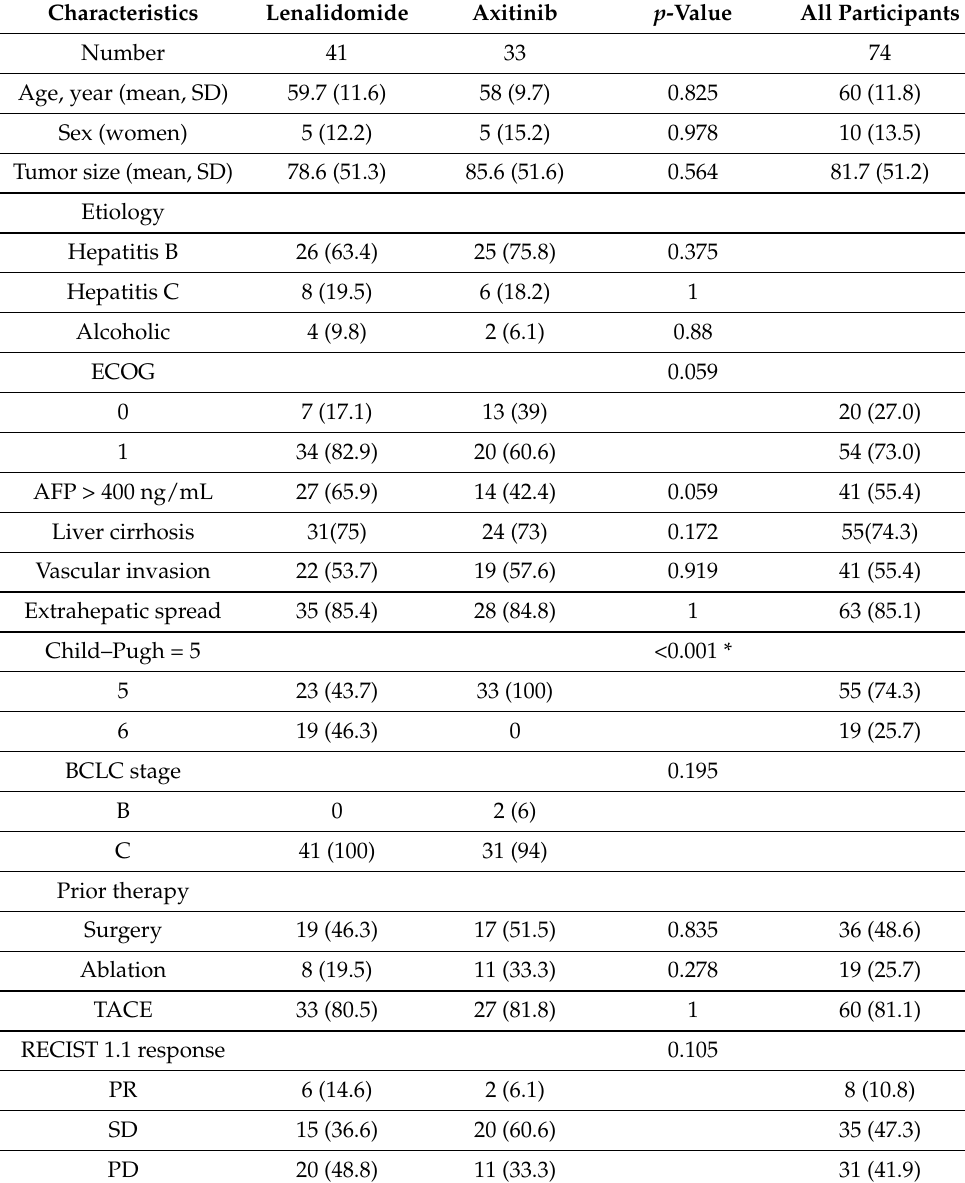
Table 1. Patient characteristics and treatment